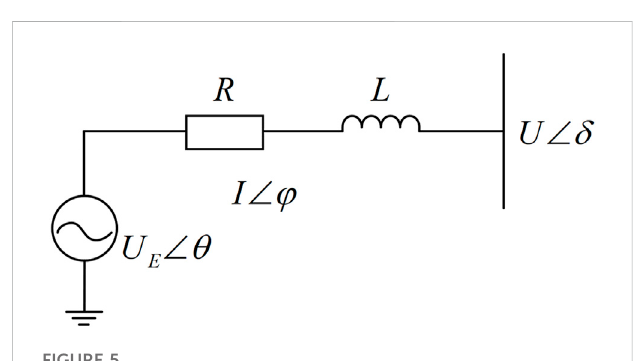
FIGURE 5 Charging and discharging schematic diagram of the ES